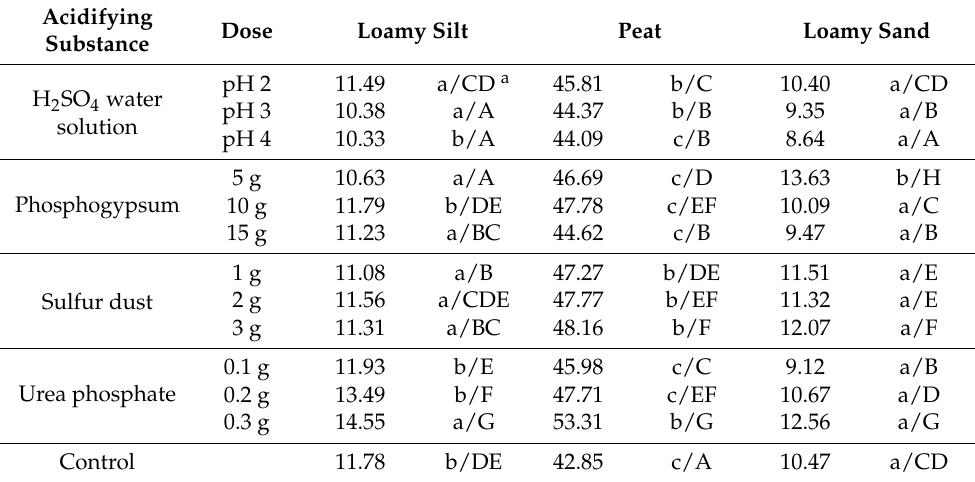
Table 3. Effects of acidifying substances after 12 months on total nitrogen in loamy silt, peat and loamy sand